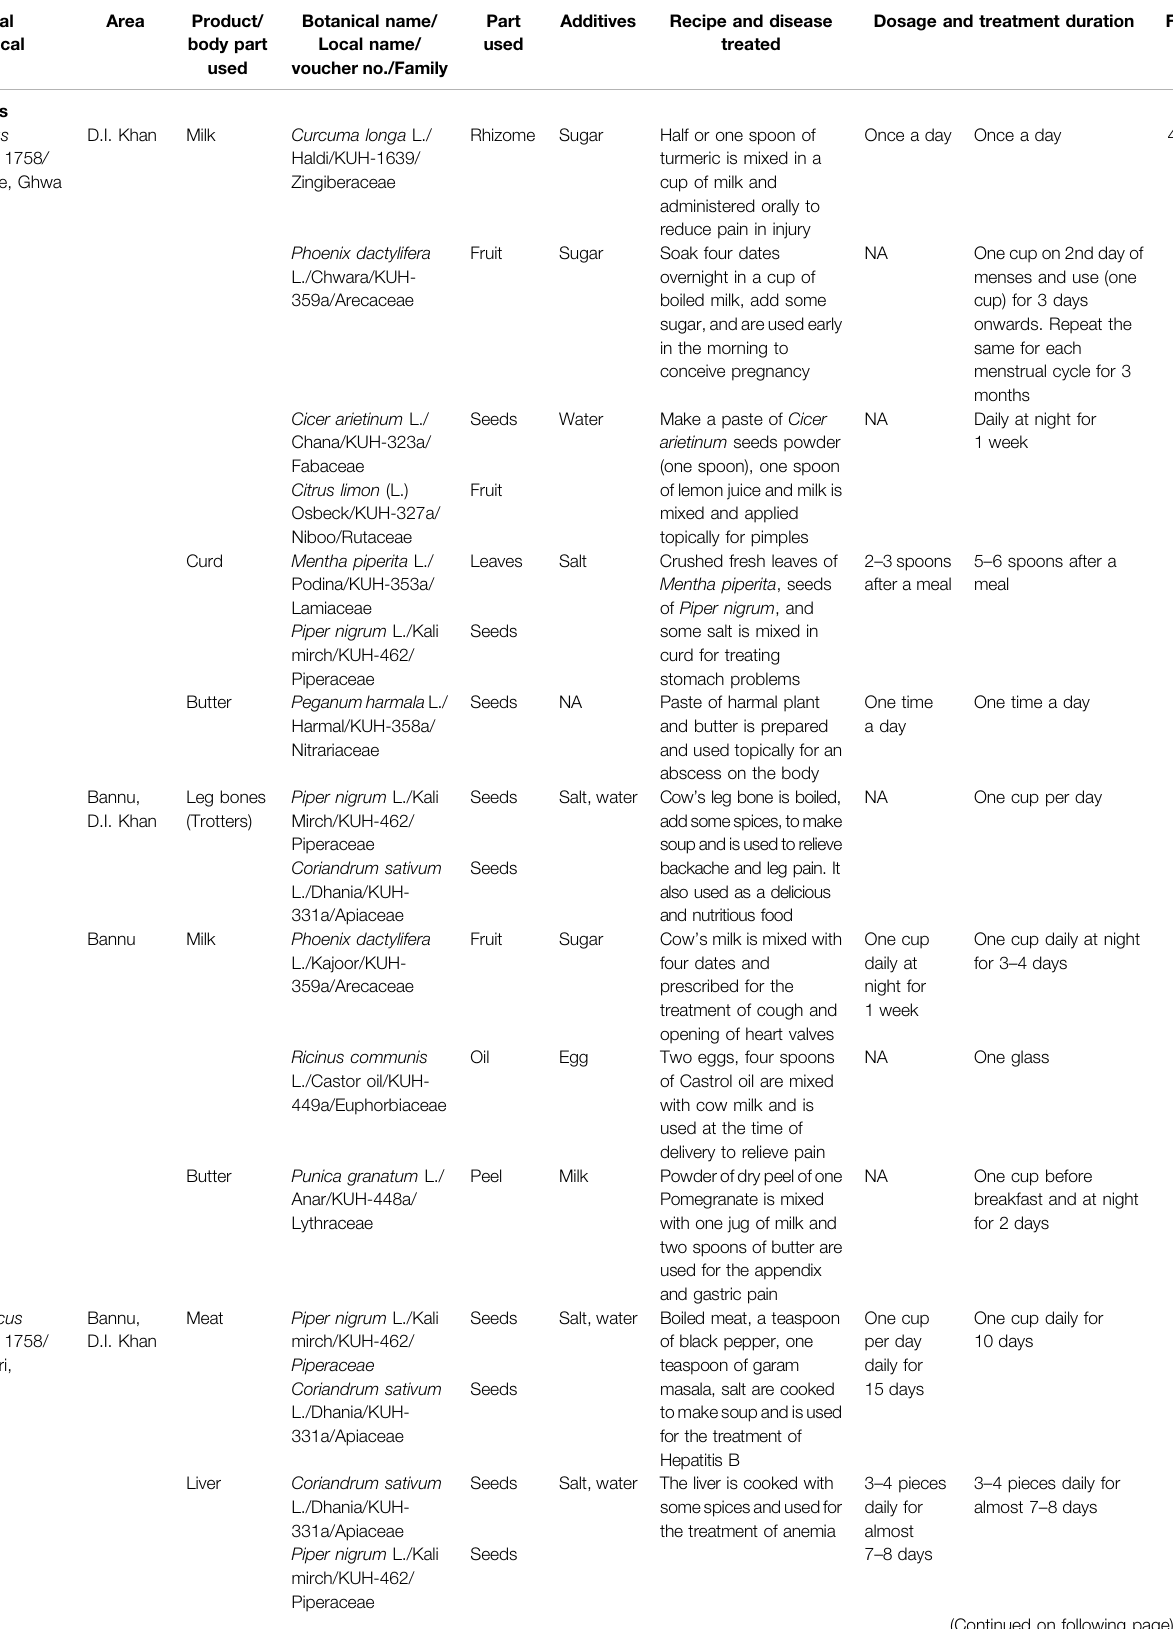
TABLE 3 | Medicinal uses of animal-plant recipes in southern regions of Khyber Pakhtunkhwa (Pakistan). Zoological name/Local